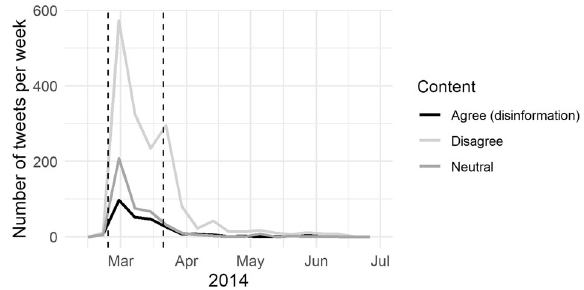
Fig. 2 The framing of Russian military presence in Crimea (in